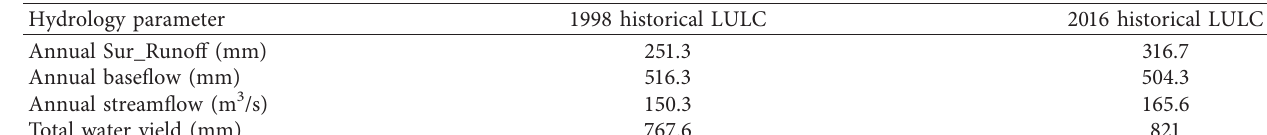
Table 10: Change in catchment hydrology parameters due to land use dynamics.